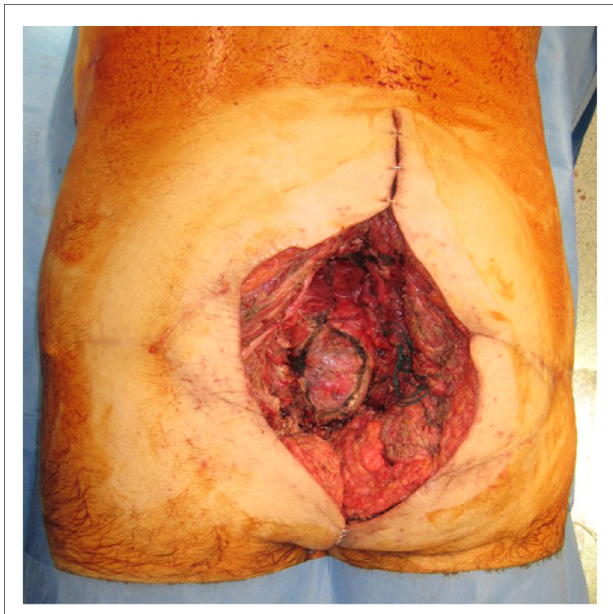
FigUre 4 | a 25 cm × 10 cm surface area sacral defect requiring reconstruction .